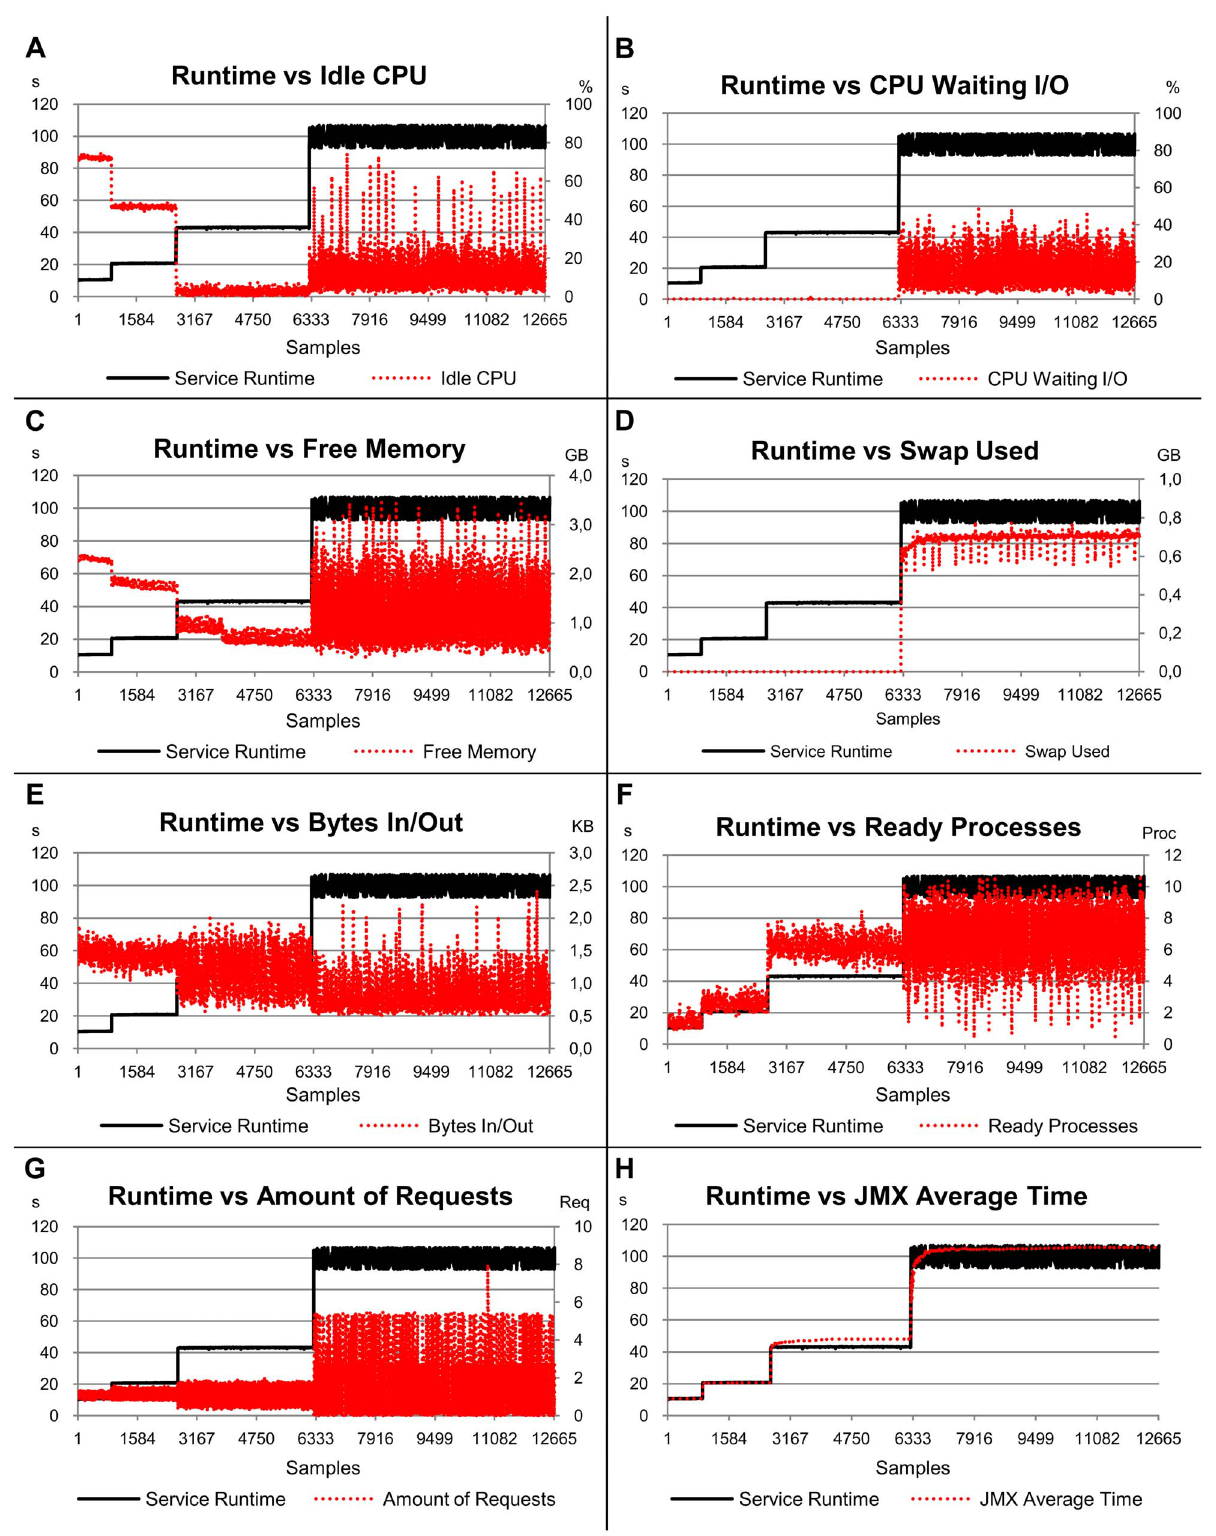
Figure 4. Relation of the service runtime versus eight load indices, considering the second scenario (memory-bound service). The left-hand scale of the y-axis always represents the service runtimes in seconds (s). The right-hand scale of the y-axis, where necessary, represents the metric used by the load index. The x-axis represents the samples collected every 10 s by Ganglia and JMX while the benchmarks were requesting services for the server.